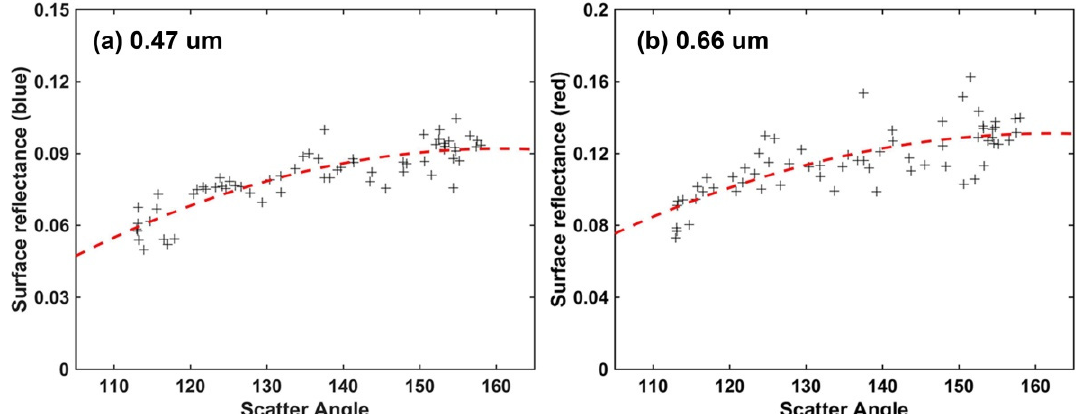
Figure 3. Example of constructing LSR from a BVA pixel over AERONET Beijing site as a function of solar and view geometry using LaSRC surface reflectance at ( a ) 0.47 and ( b ) 0.66 µ m. The red curve is the polynomial fit through the black symbols.